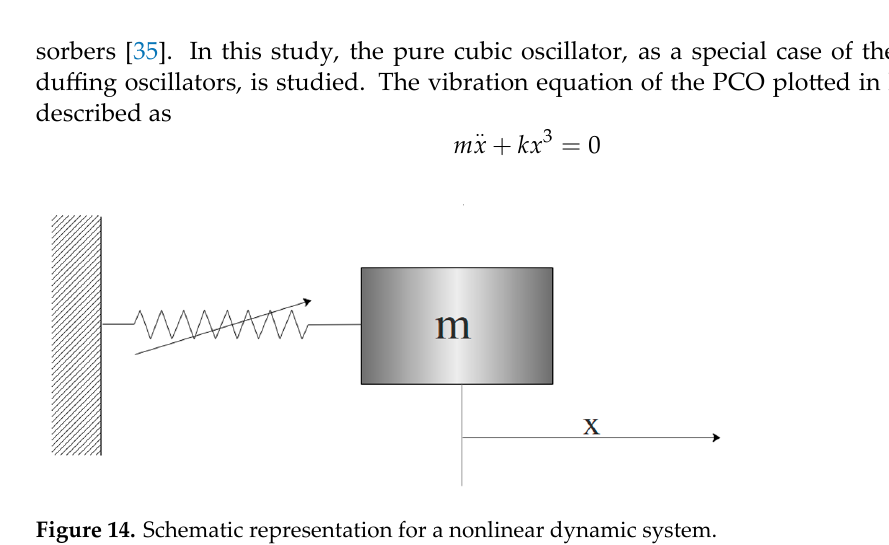
Figure 14. Schematic representation for a nonlinear dynamic system.